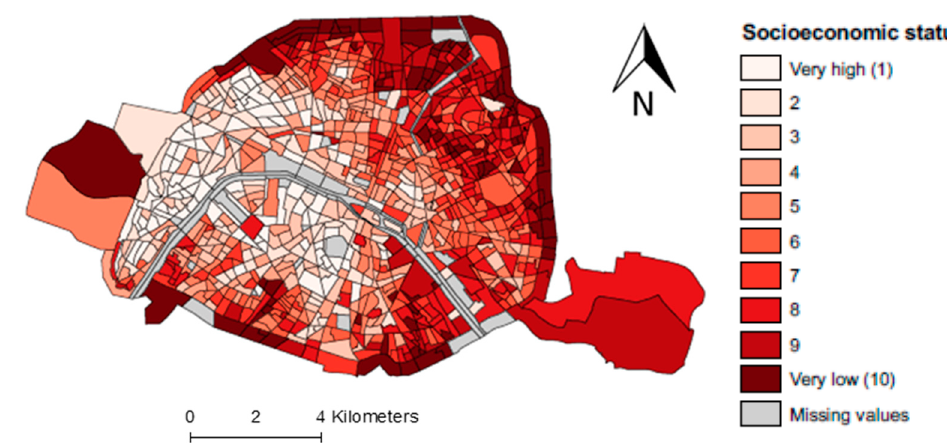
Figure 2. Spatial distribution of the socioeconomic deprivation index according to the decile of its distribution, at the census block level, Paris city.